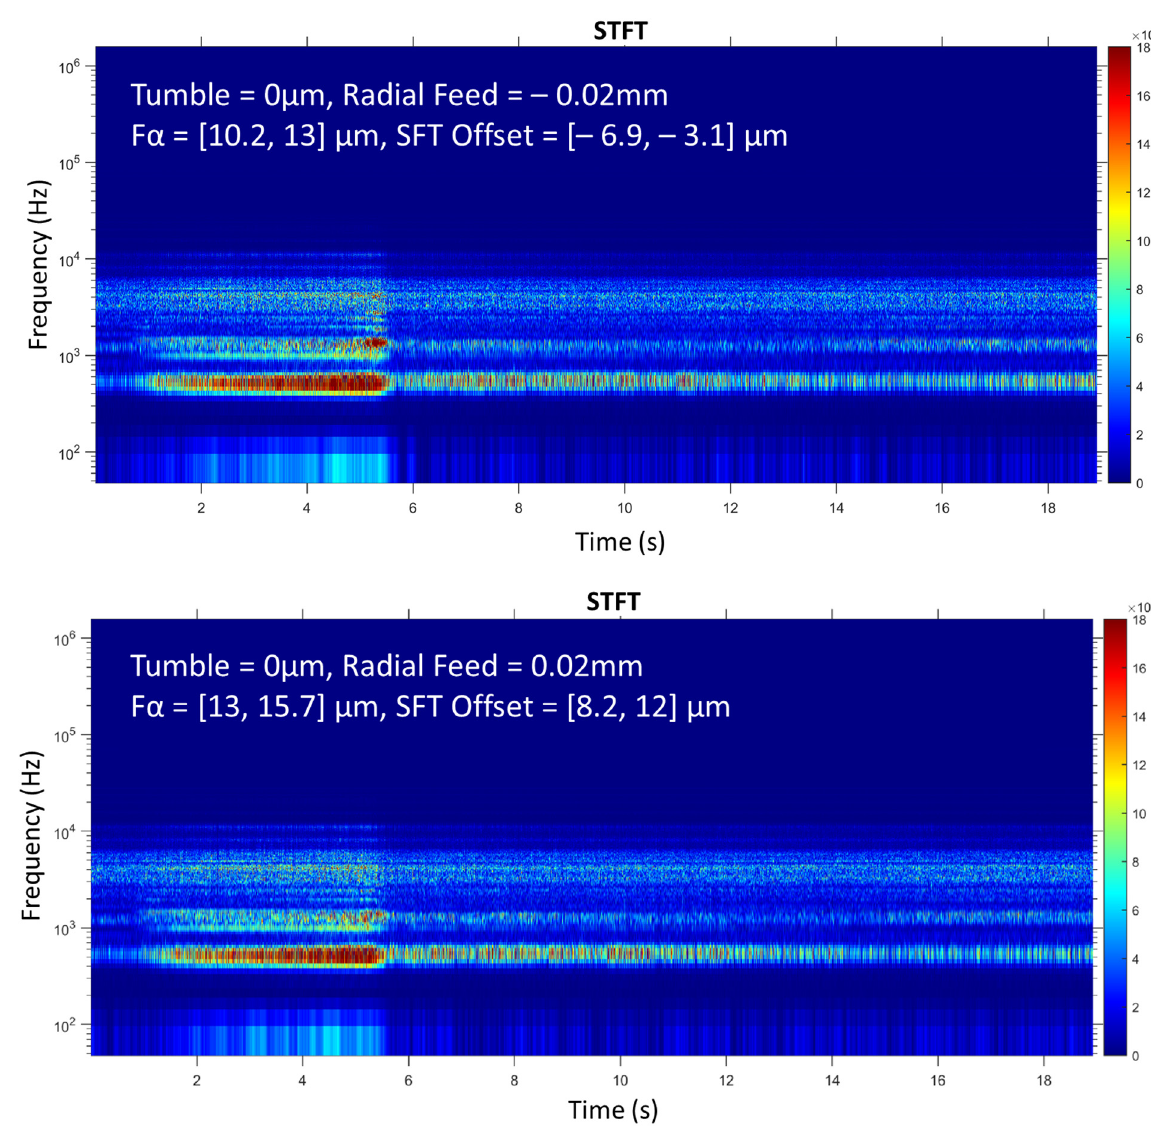
Figure 10. STFT spectra at different radial feeds and a tool tumble of 0 μ m.